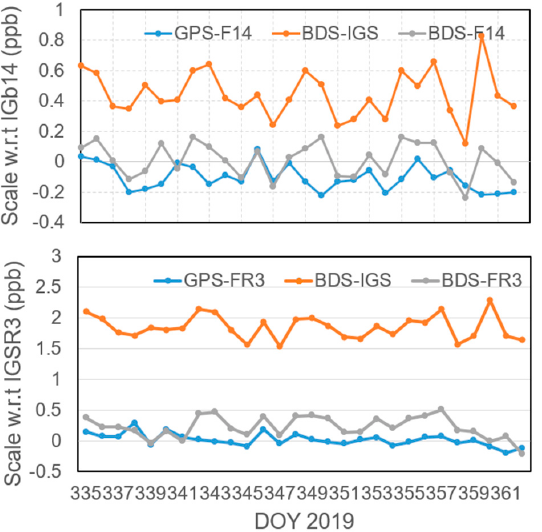
Figure 7. Scale bias between the GPS- and BDS-only precise point positioning (PPP) coordinates and the IGb14 ( up ) and IGSR3 ( bottom ) reference frame. The GPS- and BDS-only solutions based on the igs14_2102.atx antenna model and GPS-only with igsR3_2077.atx are represented as GPS-F14 as well as BDS-IGS, and GPS-FR3 respectively. The BDS-only solutions using new satellite antenna PCCs are represented as BDS-F14 as well as BDS-FR3.